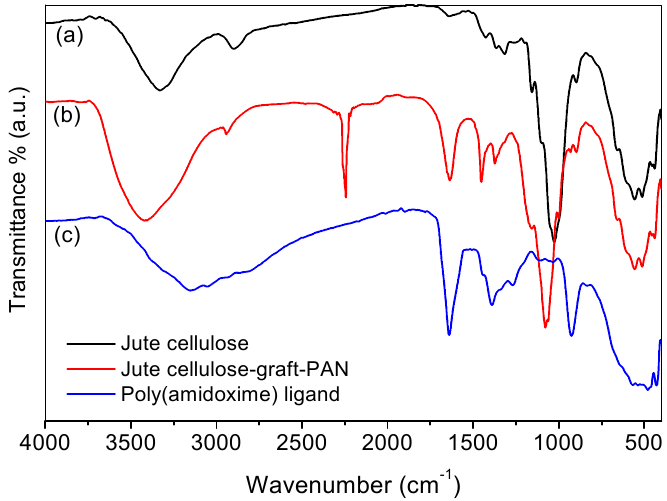
Figure 2. FT-IR spectra of ( a ) jute cellulose, ( b ) PAN-grafted cellulose and ( c ) poly(amidoxime) ligand.